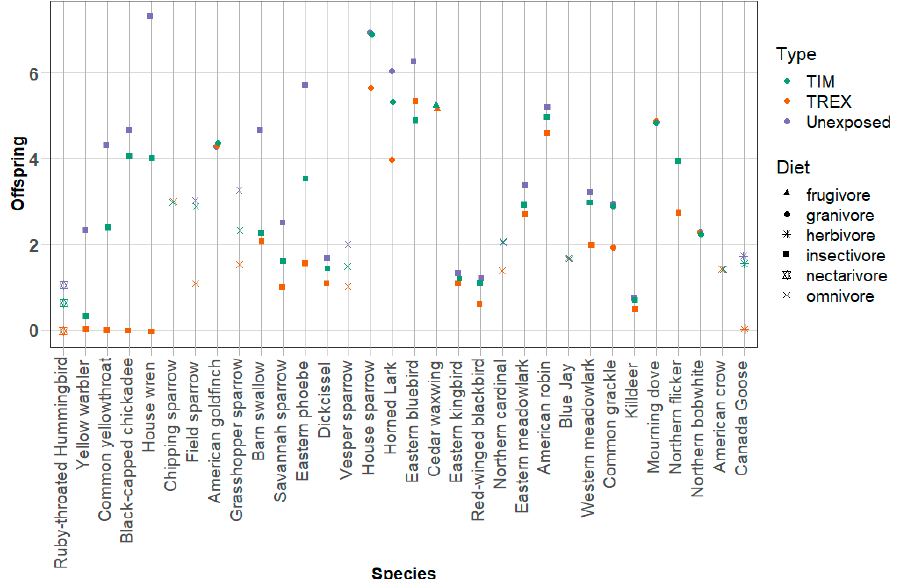
Figure 4. Estimated fecundity (offspring/breeding female/year) for 32 avian species simulated in MCnest using TIM, T-REX, and an unexposed scenario. Diet (frugivore, granivore, herbivore, insectivore, or omnivore) is determined using the MCnest feeding classes based on proportion of dietary intake; frugivore and nectarivore are added as an additional category here for species primarily foraging on fruits or nectar. The species are ordered from lowest (ruby-throated hummingbird) to highest (Canada goose) mass in grams.